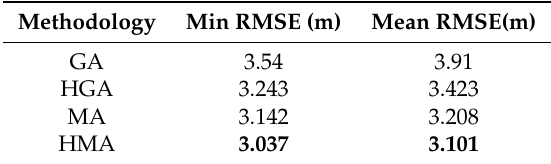
Table 7. Comparison of positioning accuracy for each methodology studied in this paper for 8 nodes. Bold results displayed refer to the mean and minimal mean RMSE of every simulation